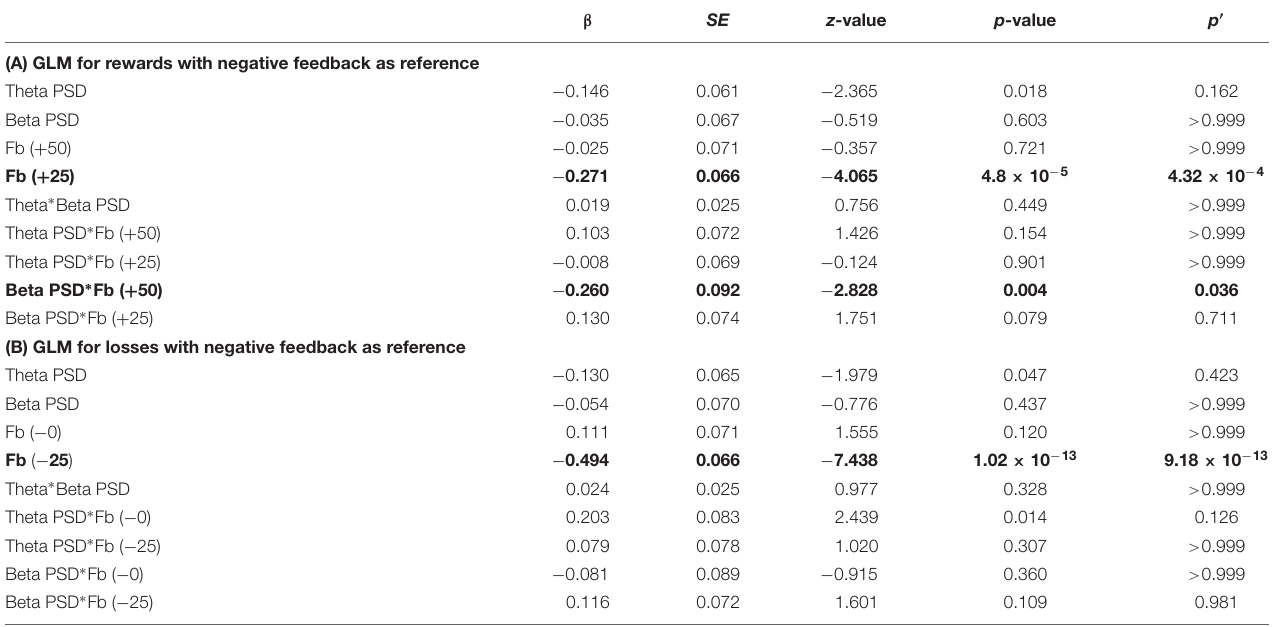
TABLE 2 | Generalized Logistic Model (GLM) predicting risk decision making in the following trial for rewards (A) and losses (B) with negative feedback as the reference variable. β SE z -value p